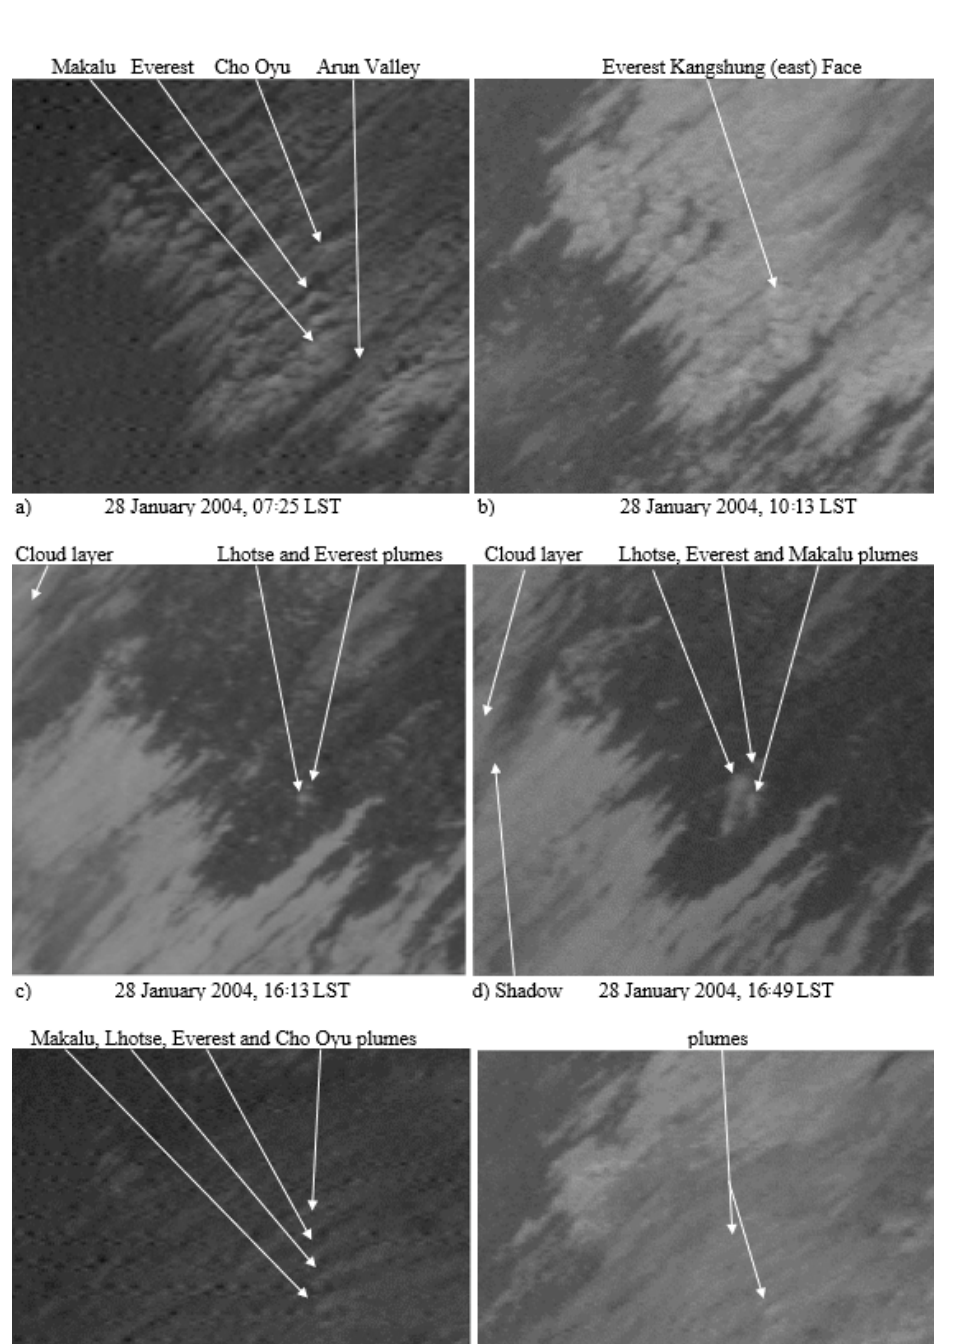
https://doi.org/10.5194/acp-22-7995-2022 Atmos. Chem. Phys., 22, 7995–8008,